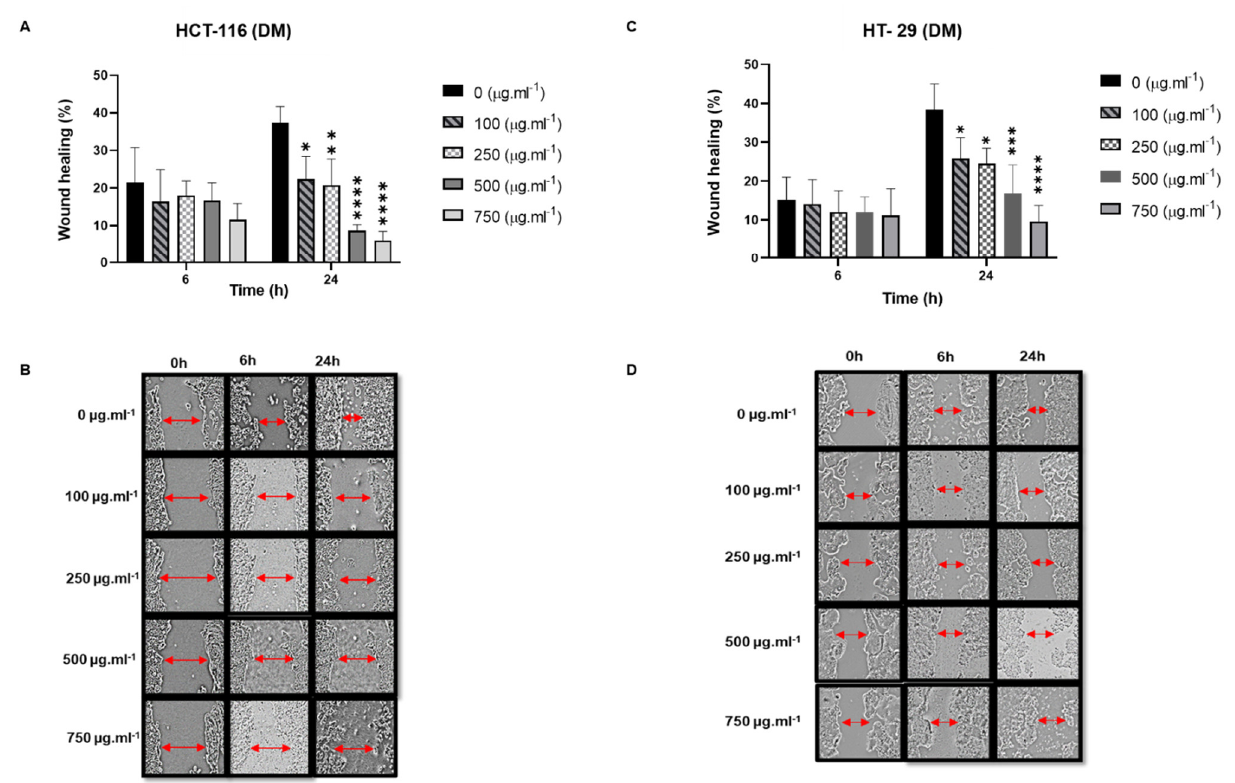
Figure 7. Wound healing assay showing that DM Soxhlet (100–250–500–750 µg.mL −1 ) inhibits the migration of HCT-116 and HT-29 cells after treatment for 24 h. ( A, B ) DM Soxhlet treatment of HCT-116: A. Percentage of wound-healing at 6 h and 24 h. B. Images of scratched HCT-116 cells taken at 0 h, 6 h, and 24 h. ( C, D ) DM Soxhlet treatment of HT-29. C. Percentage of wound-healing at 6 h and 24 h. D. Images of scratched HT-29 cells taken at 0 h, 6 h, and 24 h. Representative images were captured by a Leica microscope. Data are reported as mean ± SD, n = 3. * p < 0.05, ** p < 0.01, *** p < 0.001, and **** p < 0.0001 vs. control group. DM: dichloromethane/methanol. Anti-migratory effect of M Soxhlet extracts against HCT-116 and HT-29